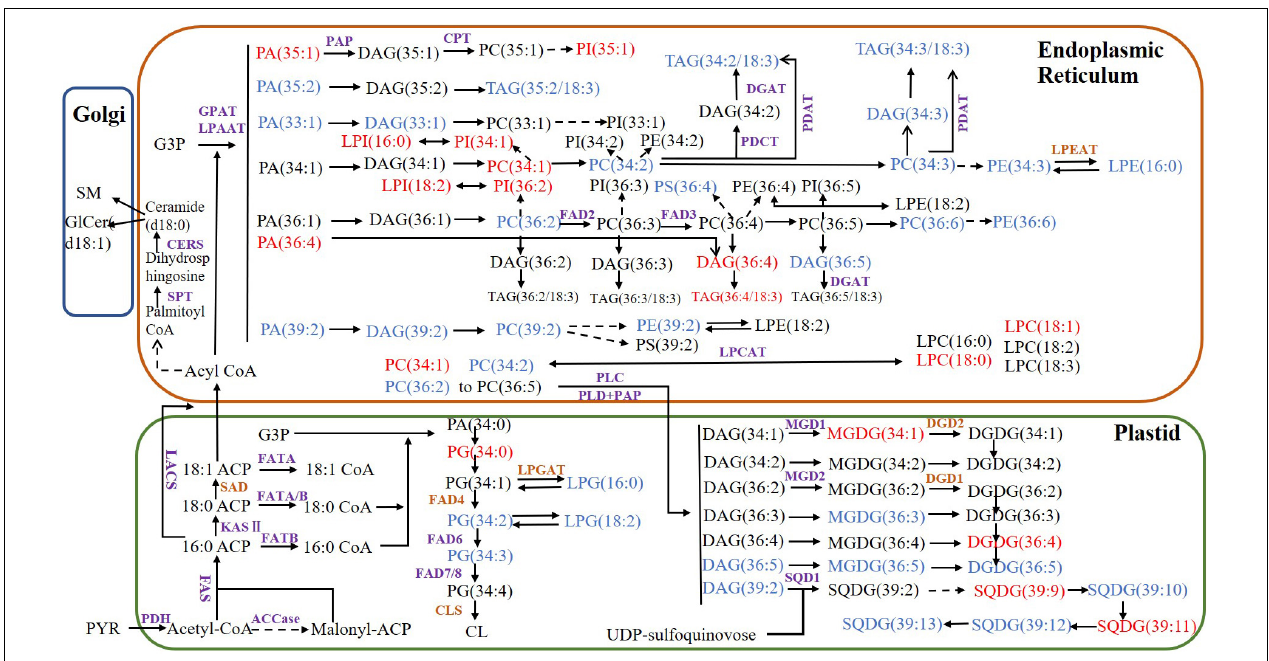
FIGURE 7 | Proposed lipid metabolism pathway map for walnut. The purple enzymes represent genes that have been detected in the transcriptome and the brown genes represent the undetected genes. The lipid molecules in blue have higher content of Xin 2 and those in red have higher content of Qingxiang. PYR, pyruvate; ACP, acyl carrier protein; PDH, pyruvate dehydrogenase; ACCase, acetyl-CoA carboxylase; acyl CoA, acetyl-coenzyme A; FAS, fatty acid synthase; SAD, stearoyl-ACP desaturase; LACS, long-chain acyl-CoA synthetase; CPT, CDP-choline:diacylglycerol cholinephosphotransferase; KASII: 3-ketoacyl-ACP synthase; DGAT, diacylglycerol acyltransferase; FAD2, oleoyl desaturase; FAD3, linoleoyl desaturase; FAD4, FAD6, FAD7/8, fatty acid desaturase; GAP, glyceraldehyde-3-phosphate; GPAT, glycerol-3-phosphate acyltransferase; LPAAT, lysophosphatidic acid acyltransferase; PDAT, phospholipid:diacylglycerol acyltransferase; PDCT, phosphatidylcholine:diacylglycerol cholinephosphotransferase; PEP, phosphoenolpyruvate; MGD, monogalactosyldiacylglycerol synthase; DGD, digalactosyldiacylglycerol synthase; SQD, sulfoquinovosyldiacylglycerol synthase; CLS, cardiolipin synthase; SPT, serine palmitoyltransferase; CERS, ceramide synthase; SMS, sphingomyelin synthase; LPEAT, lysophosphatidylethanolamine acyltransferase; LPCAT, lysophosphatidylcholine acyltransferase; PLC, phospholipase C; PLD, phospholipase D; PAP, phosphatidic acid